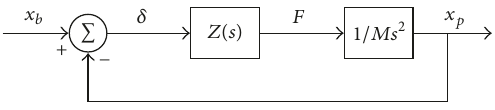
Figure 3: General isolator block diagram.